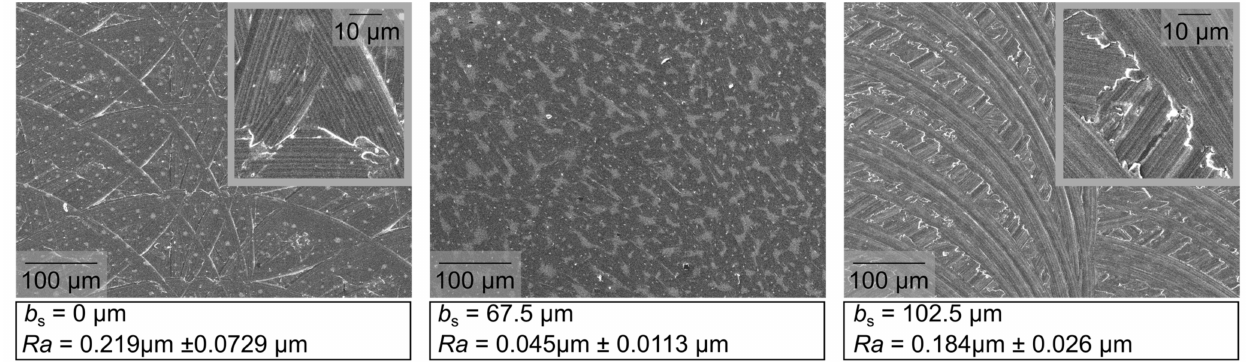
Figure 11. SEM measures of the surface finish for the parallel land b s = 67.5 µ m and 102.5 µ